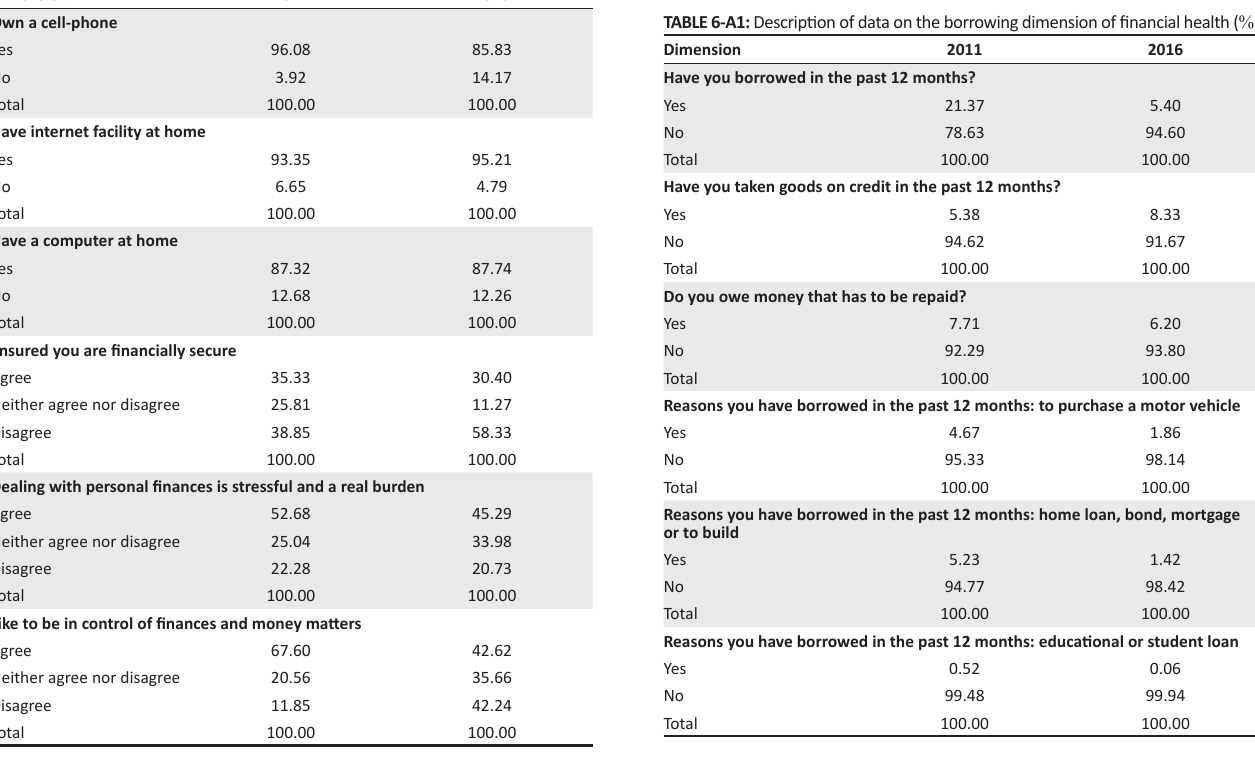
TABLE 4-A1: Description of data on the welfare dimension of financial inclusion ( % ). Dimension